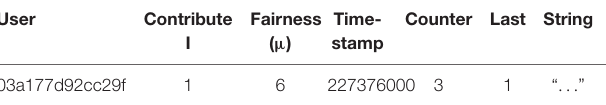
TABLE 5 | Example of transaction details in the Blockchain implementation. User Contribute Fairness Time- Counter Last String I ( µ ) stamp 03a177d92cc29f 1 6 227376000 3 1 “ ...